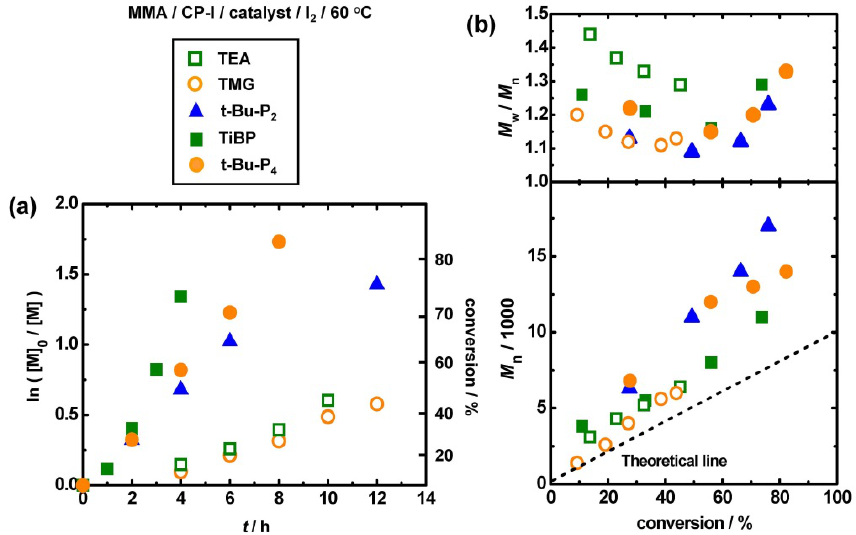
Figure 5. Plots of ( a ) ln([M] MMA/CP–I/catalyst systems (in bulk) (60 °C) (entries 4, 5, 7, 9 and 11 in Table 1):